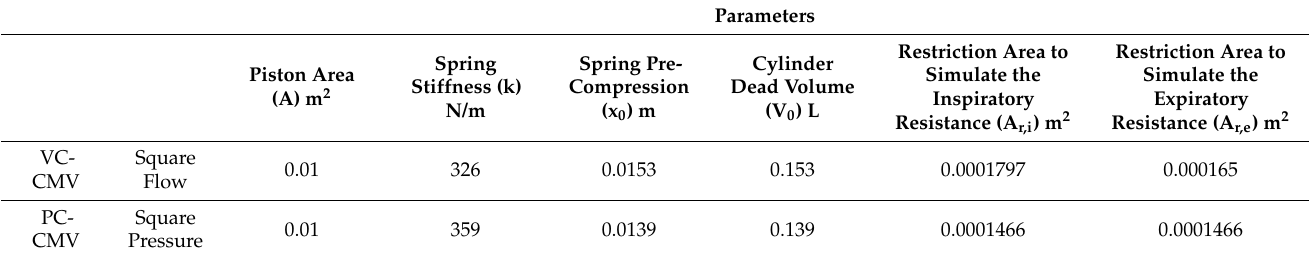
Table 8. Parameters set in the subroutine “Patient” concerning simulations of real-life cases of the Case